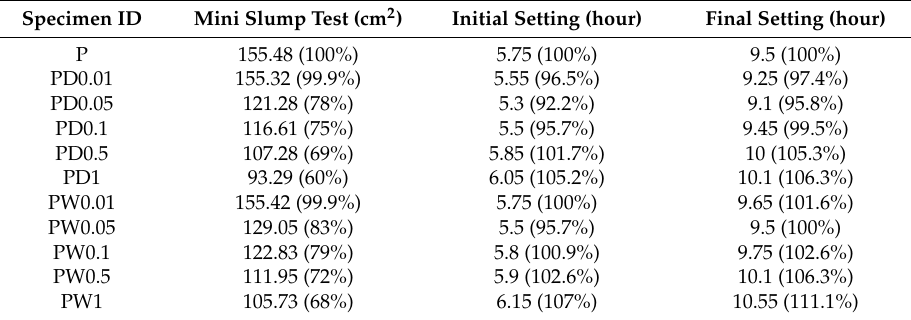
Table 5. The results of mini slump tests, initial and final setting